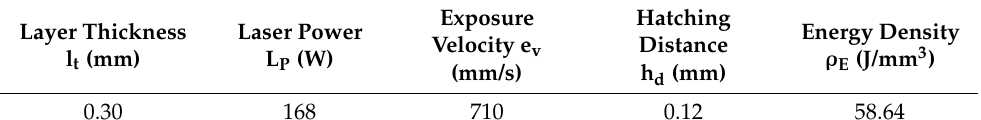
Table 1. Parameters used for samples manufacturing.